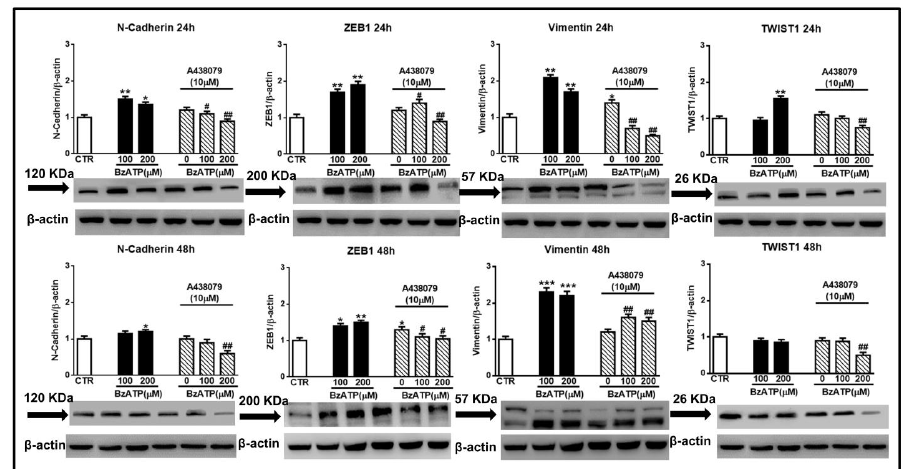
Figure 6. Blockade of the BzATP effect on EMT markers by the P2X7R selective antagonist A438079. Confluent GSCs were exposed to different concentrations of BzATP, alone or in the presence of the P2X7R antagonist, A438079 added 1 h before BzATP administration. Immunoblots were re-probed with an antibody against β actin, quantified by densitometric analysis, normalized to β actin used as an internal control, and reported in the histograms assuming the value of control / β -actin = 1. β -actin bands are the same for some blots reported in the figure, since they were obtained by cutting the same membrane at different heights corresponding to the molecular weights of the selected markers. Immuno-bands reported in the figure are representative of three independent experiments carried out in GSCs #3. * p < 0.05, ** p < 0.01, *** p < 0.001: statistical significance vs. untreated GSCs assumed as control (CTR); # p < 0.05, ## p < 0.01: statistical significance vs. GSCs treated with BzATP (one-way ANOVA plus Dunnett’s test). Cells 2019 , 8 , x FOR PEER REVIEW